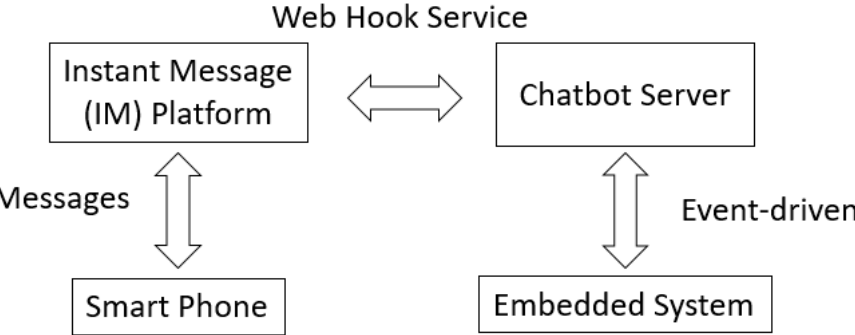
Figure 11. The software’s functional architecture of this